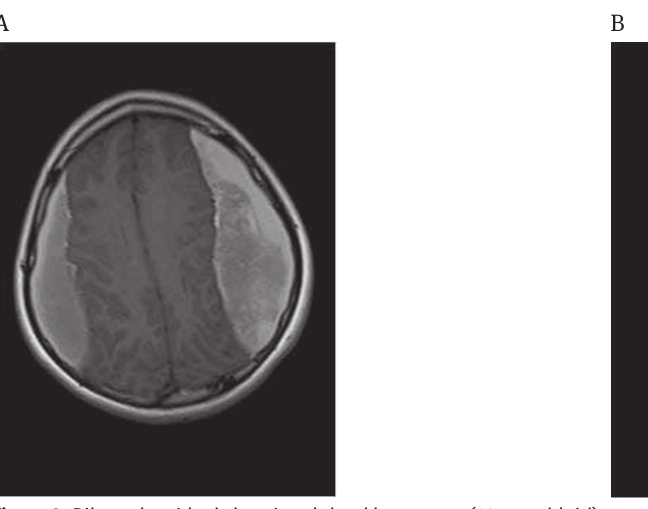
Figure 2: Bilateral residual chronic subdural hematoma (14 yearoldgirl); A: Preoperative, Axial T1-weighted MRI; Bilateral hyperintense parietal subdural